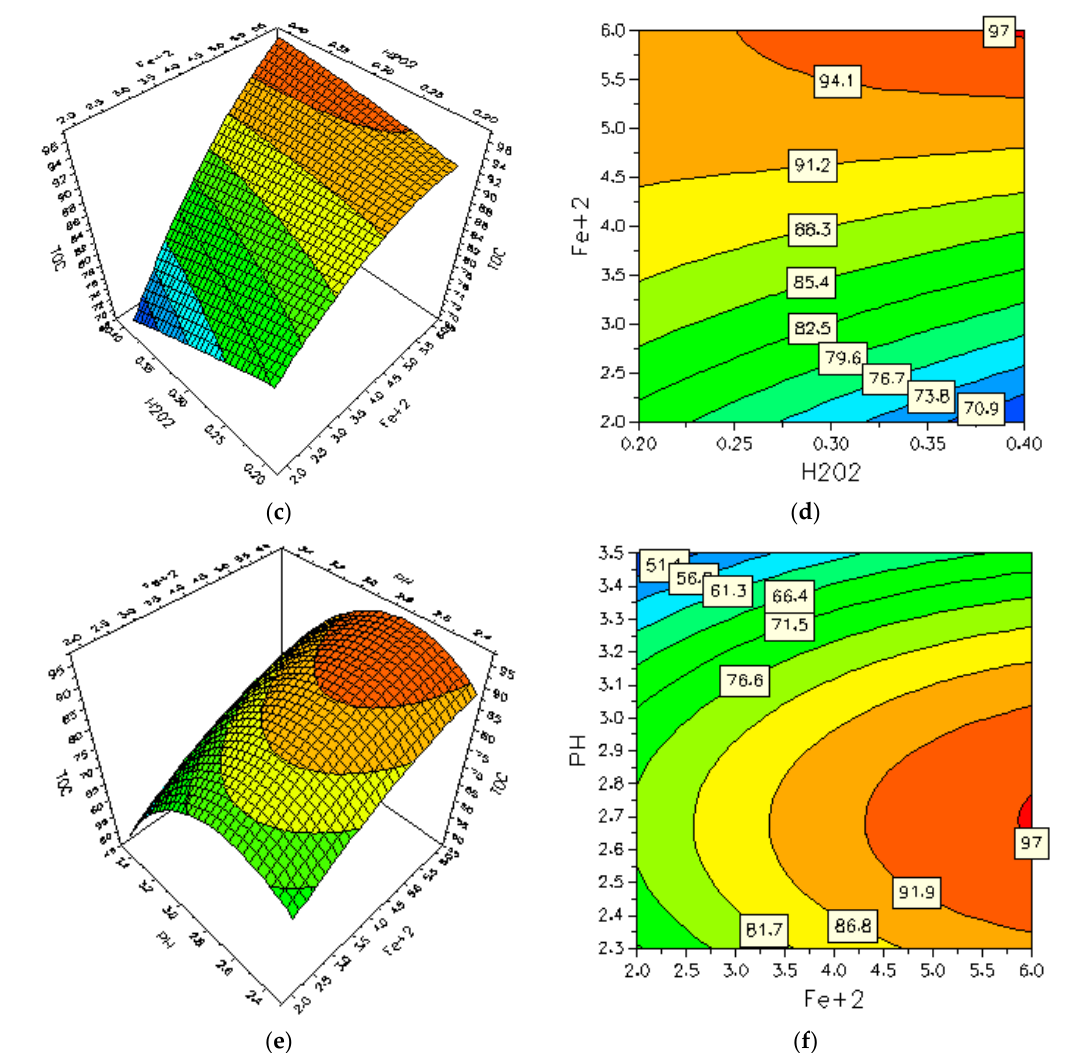
Figure 3. Effects of pH, H 2 O 2 and Fe 2+ initial concentration on TOC removal rate. ( a , b ) Fe 2+ concentration was kept constant at 4 mg ∙ L − 1 ; ( c , d ) H 2 O 2 concentration was kept constant at 0.3 g ∙ L − 1 ; ( e , f ) pH value was kept constant at 2.9.